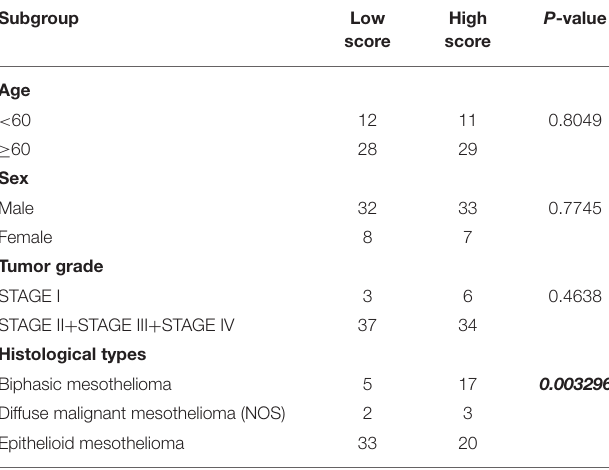
TABLE 4 | Statistical analyses between the clinical traits and the risk model.